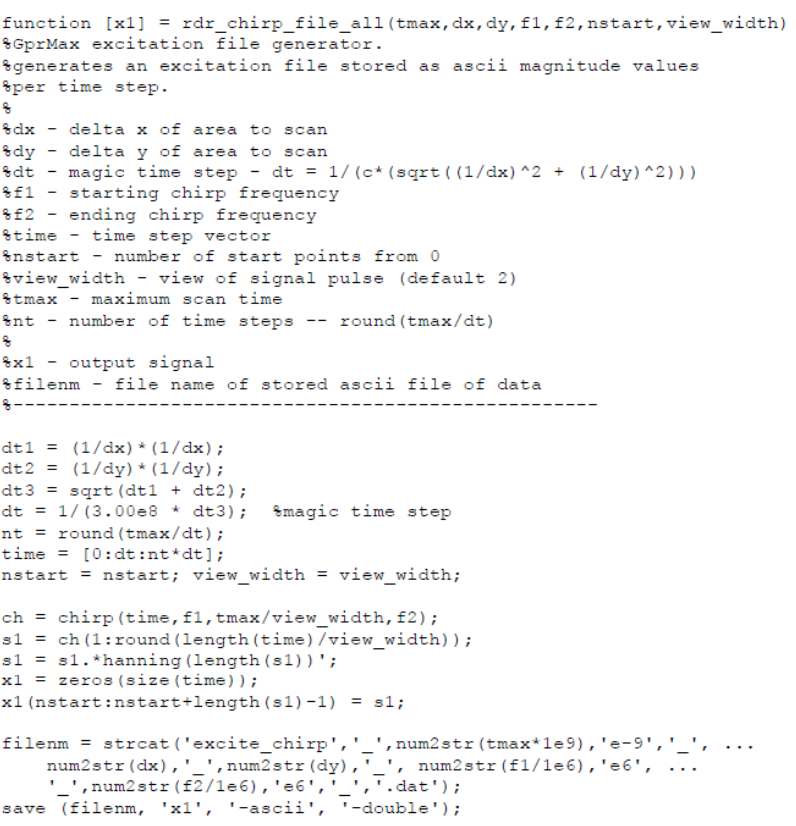
Figure 1. Chirp signal MATLAB code. Figure 1. chirp signal MATLAB code. Figure 1. chirp signal MATLAB code.